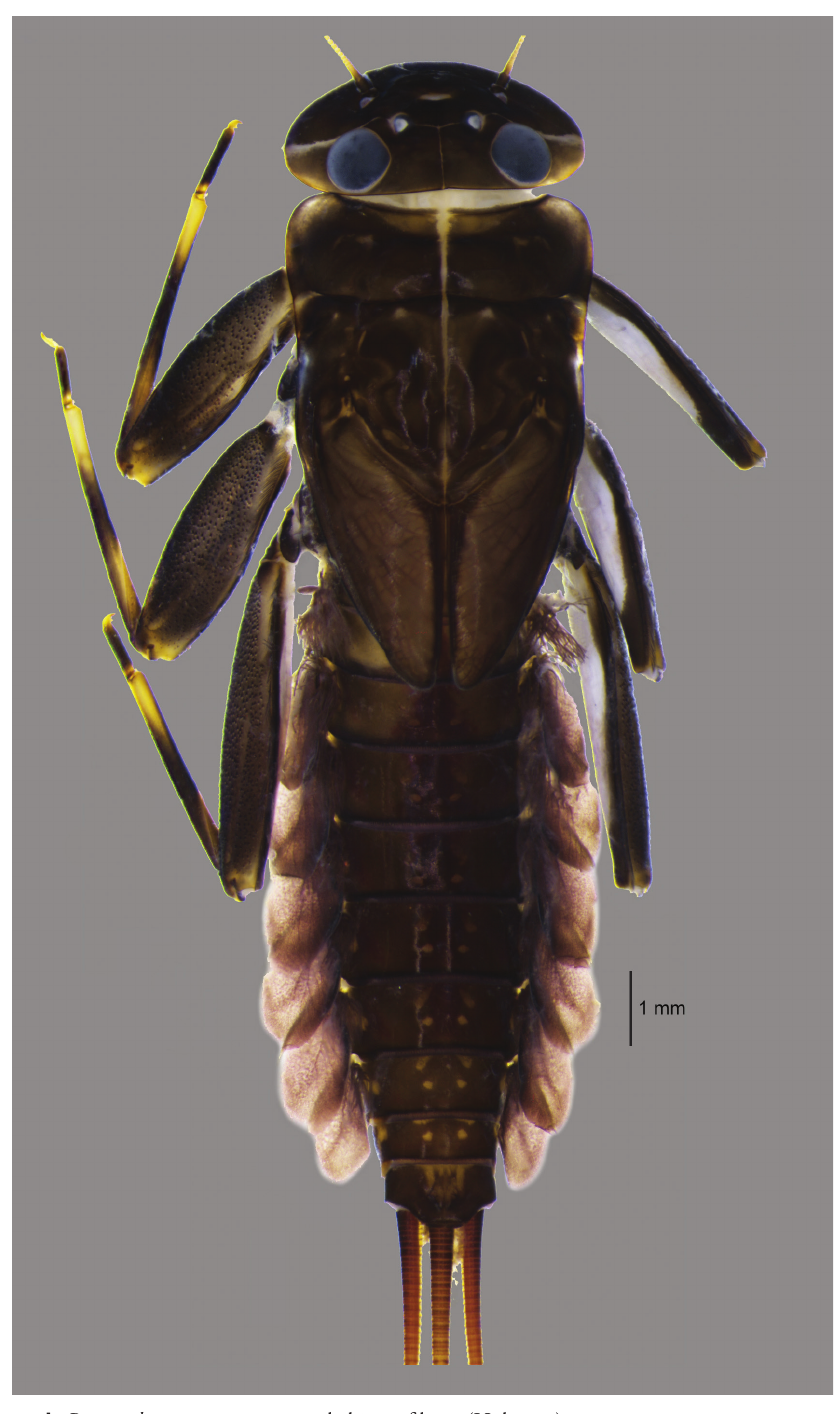
Figure 1. Paegniodes sapanensis sp. nov., habitus of larva